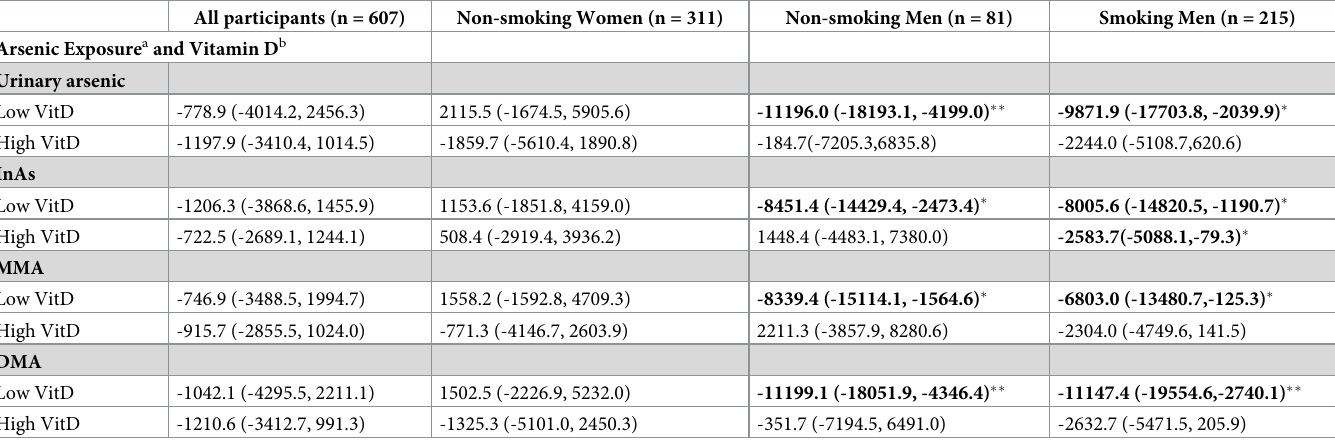
Table 4. Estimated coefficient of arsenic exposure in linear models for CD3-CD28 stimulated T-cell proliferation by low and high vitamin D (VitD) levels. All participants (n = 607)